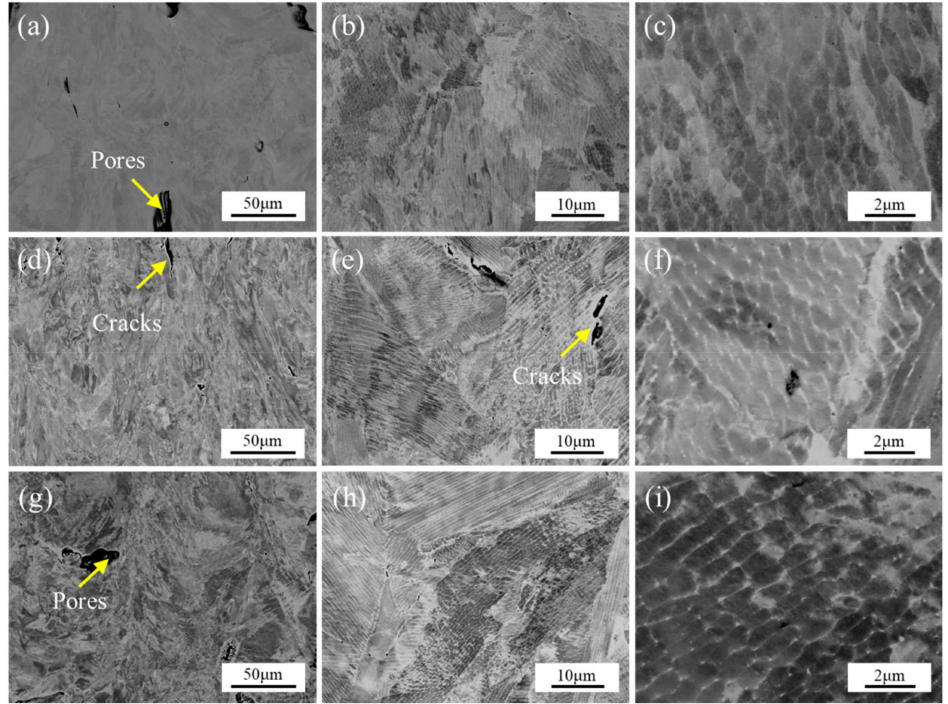
Figure 5. Microstructure changes before heat treatment: ( a – c ) transverse microstructure; ( d – f ) longi- tudinal microstructure; and ( g – i ) 45 ◦